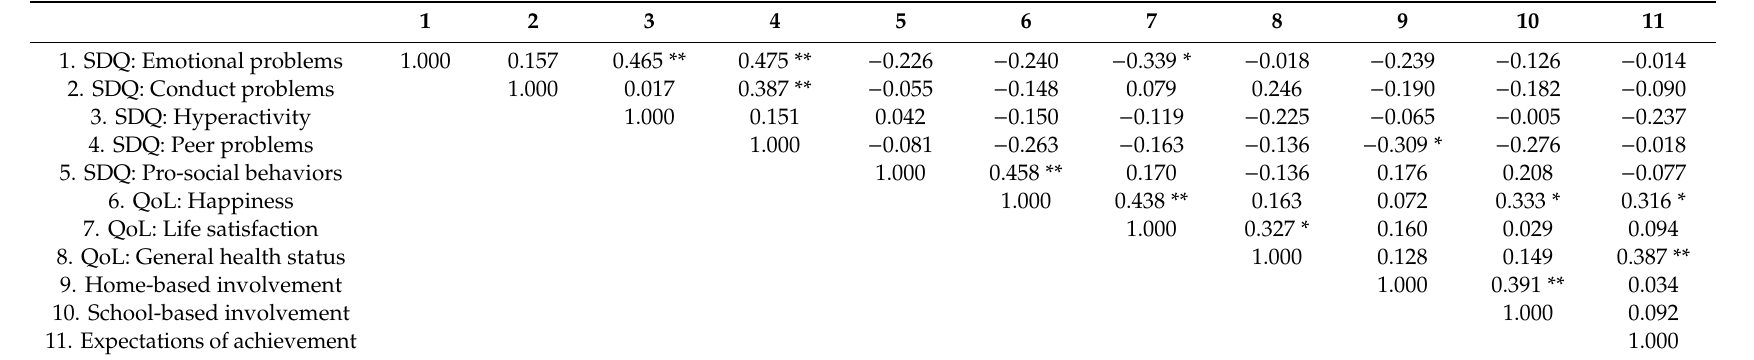
Table 5. Inter-correlations of study variables among shidu families ( n =